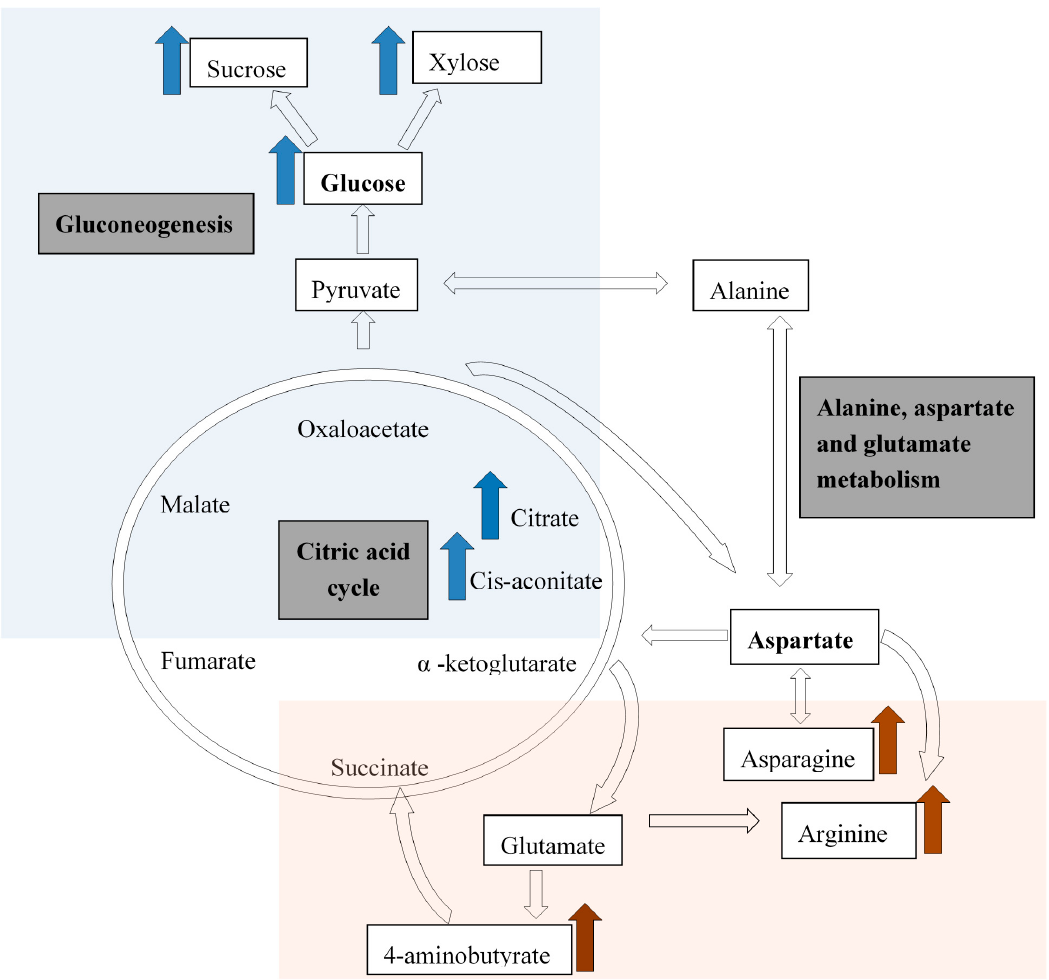
Figure 3. A simplified diagram indicating the citric acid cycle, the important metabolic pathways affected, and the resultant compounds that were increased during water-stressed (brown; 50% and 70% ADL) and well-watered conditions (blue; 30% ADL) adapted from previous researches [32,34], in Pelargonium sidoides.